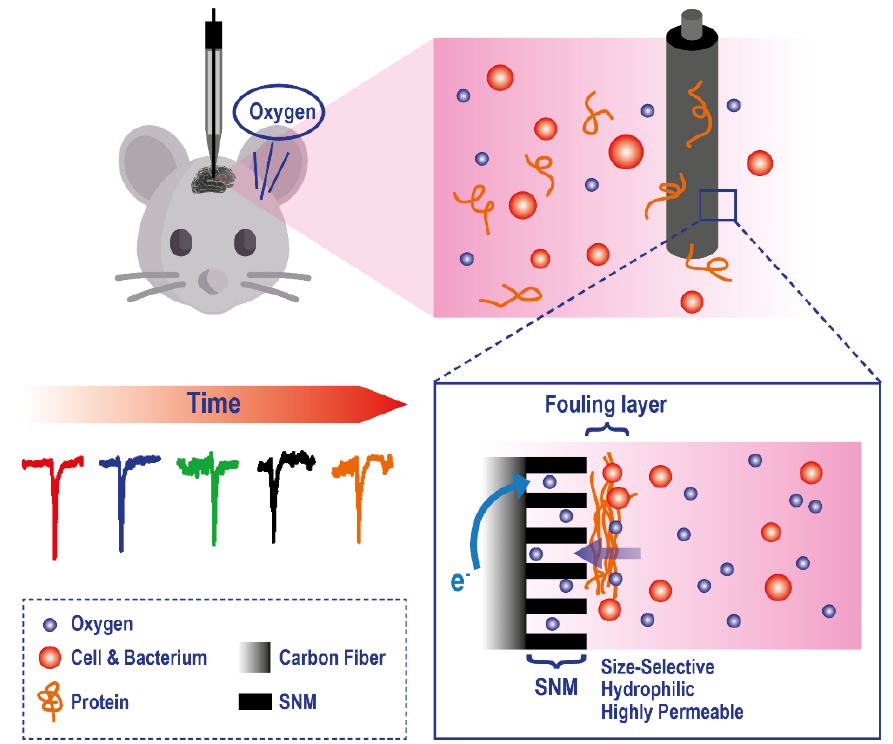
Figure 9. Example of a microelectrode exploiting a Silica and Gold Nanochannel Membrane to monitor in vivo O 2 levels on rat brain. Adapted with permission from [142].